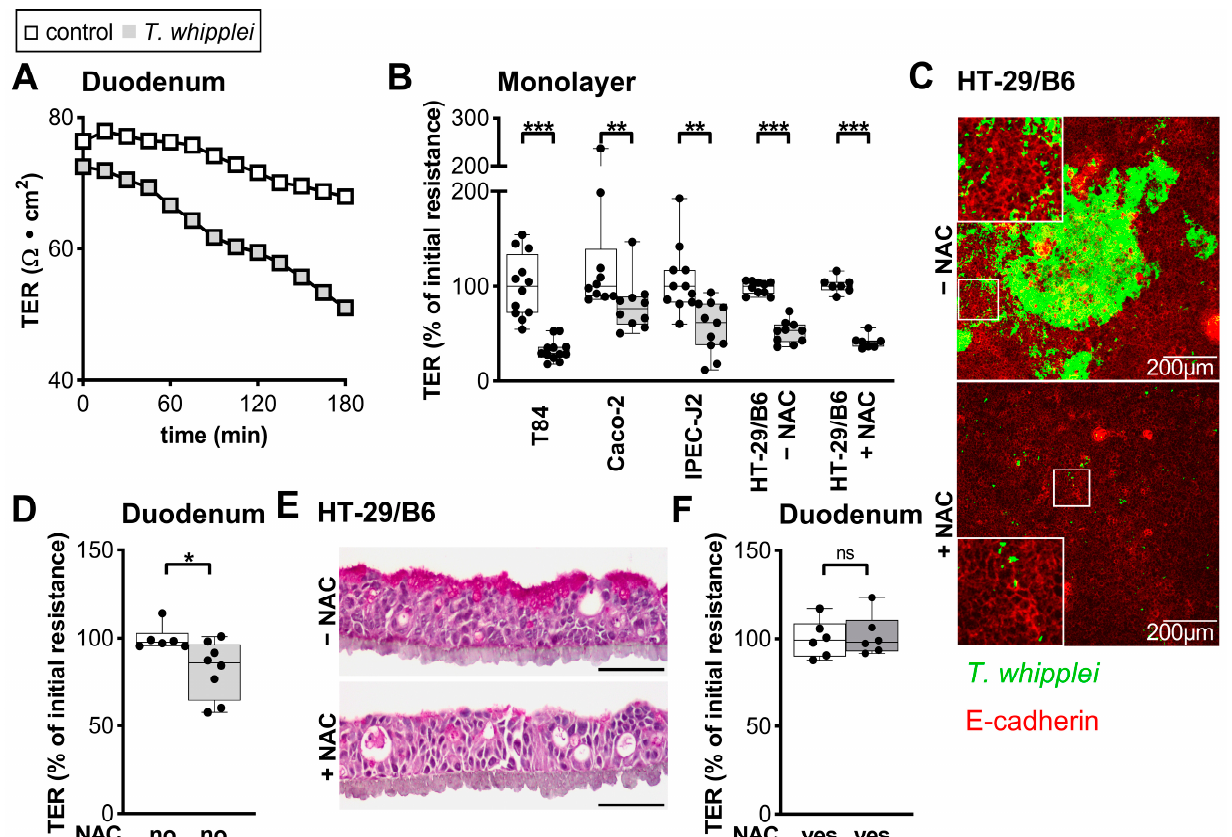
Figure 4. T. whipplei interrupts epithelial barrier. ( A ): Representative time course of barrier defect of human duodenal mucosa inoculated ex vivo with TW . ( B , D ): TW -dependent decrease in transepithelial resistance (TER) in T84, Caco-2, IPEC-J2, and HT-29/B6 monolayers (24 h inoculation, multiplicity of infection = 100) and human duodenal mucosa (3 h inoculation, 10 7 bacteria per Ussing chamber). Graphs depicting single values, median, and minimum to maximum, n = 6–12, * p < 0.05, ** p < 0.01, *** p < 0.001. ( C – F ): Role of the mucus layer in TW -induced barrier defect. Pretreatment of HT-29/B6 with N -acetylcysteine (NAC). ( C ): Immunofluorescence staining (performed after 24 h inoculation and washing steps). NAC reduces apical adherent TW which remains after performing apical washing steps. TW , green; E-cadherin, red. Size bars, 200 µ m. ( E ): Periodic acid-Schiff staining of HT-29/B6 monolayers reveals a reduced apical mucus layer after treatment with 10 mM NAC. Size bars, 20 µm. ( F ): NAC pretreatment prevents epithelial barrier defect by TW , as revealed by TER measurement in Ussing chambers 3 h after TW inoculation. Notably, the apical fluid compartment recirculates compared to the static conditions during monolayer experiments. Bars represent single values, median, and minimum to maximum, n = 6, ns: not significant.